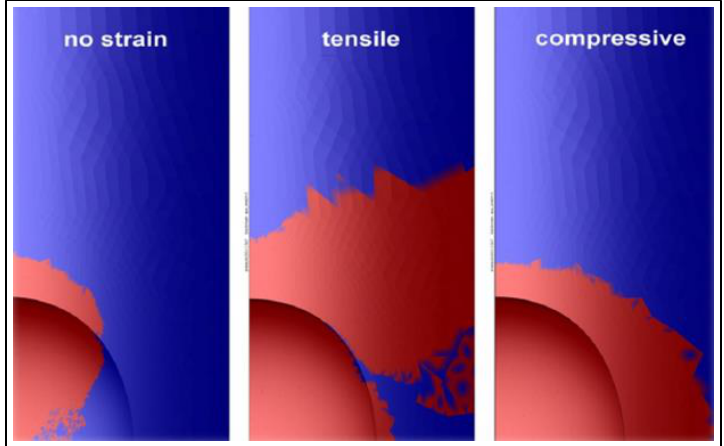
Figure 7. Plastic deformation distribution on X80 grade steel pipe when subjected to no external strain ( left ), 0.2% tensile strain ( middle ), 0.2% compressive strain ( right ) [62].